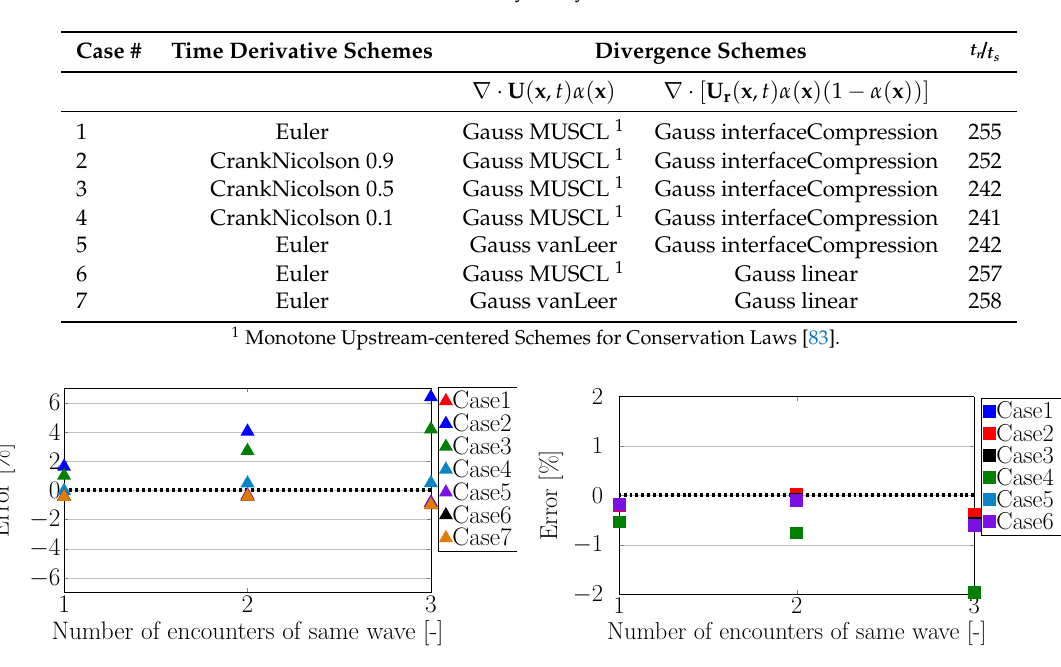
Table 8. Test matrix for the sensitivity analysis to numerical solution schemes.